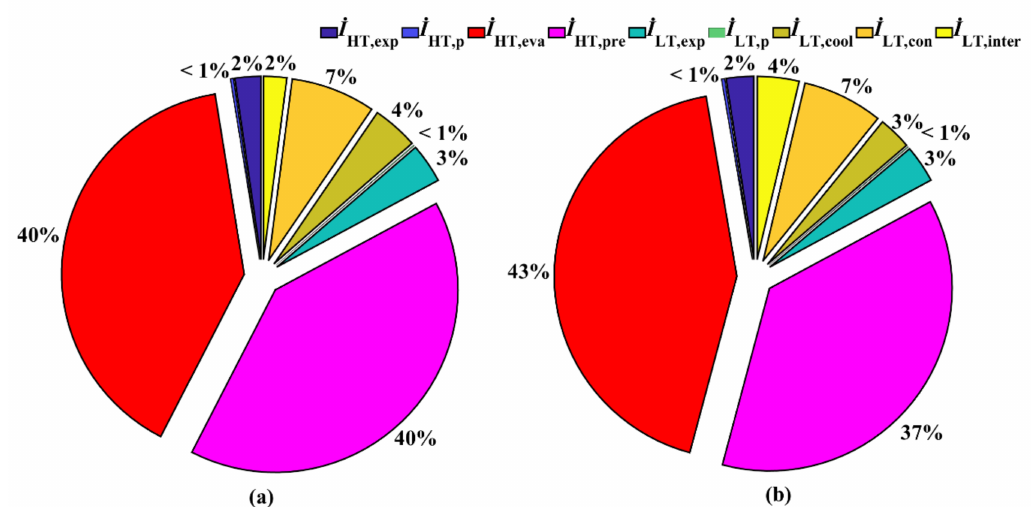
Figure 11. The proportion of exergy destruction of key components. ( a ) proportion of the average exergy destruction of key components. ( b ) proportion of exergy destruction of key components of the DORC